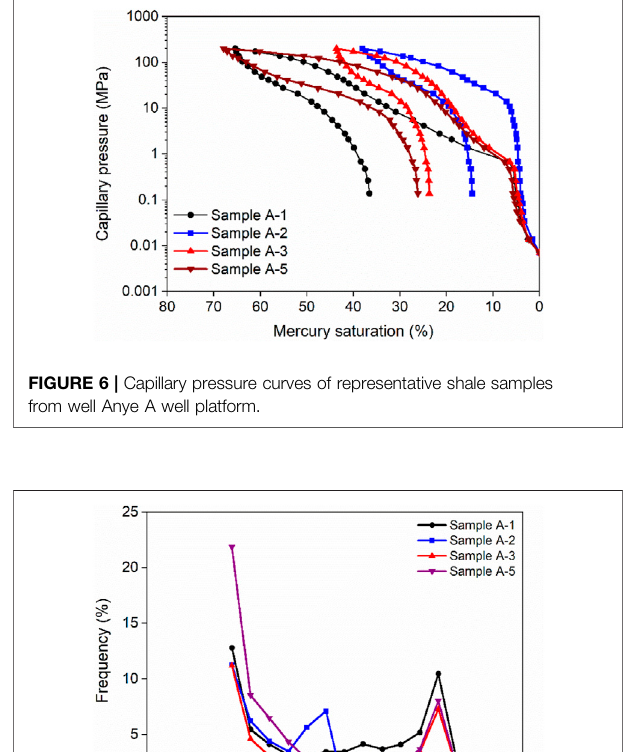
Frontiers in Earth Science |